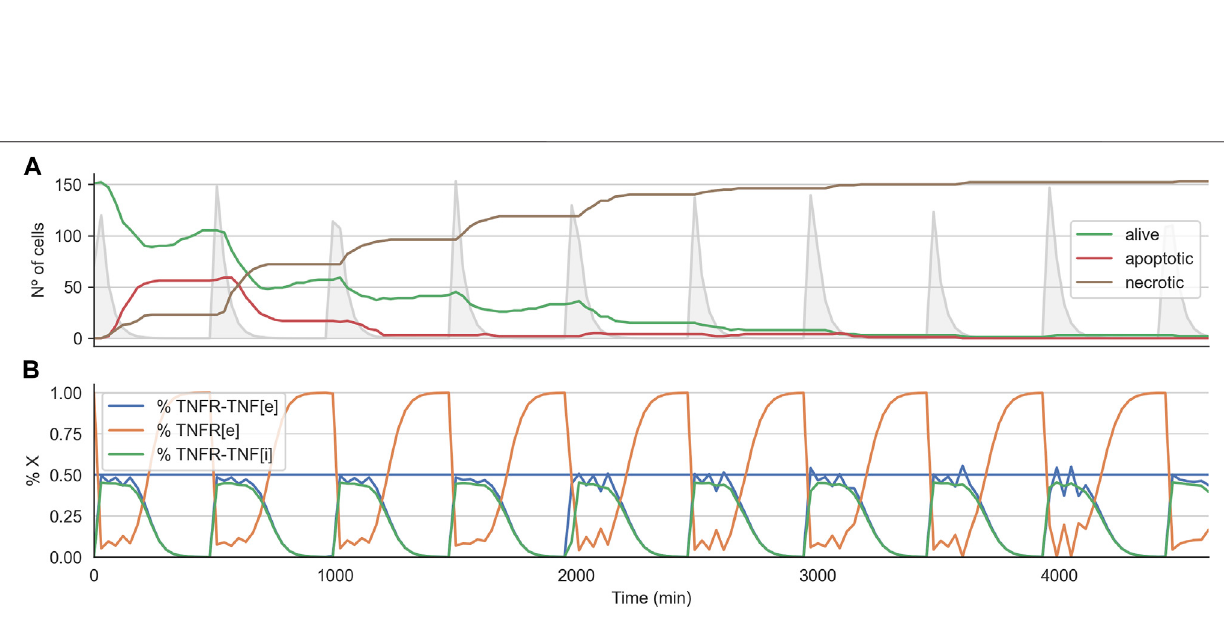
Frontiers in Molecular Biosciences |